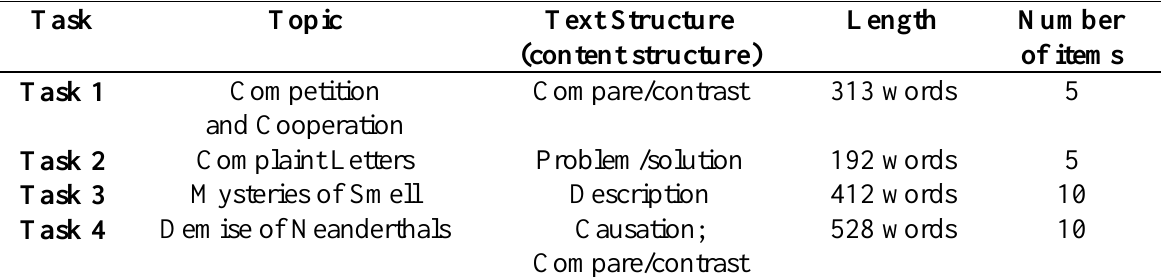
Analysis of the Reading Tasks